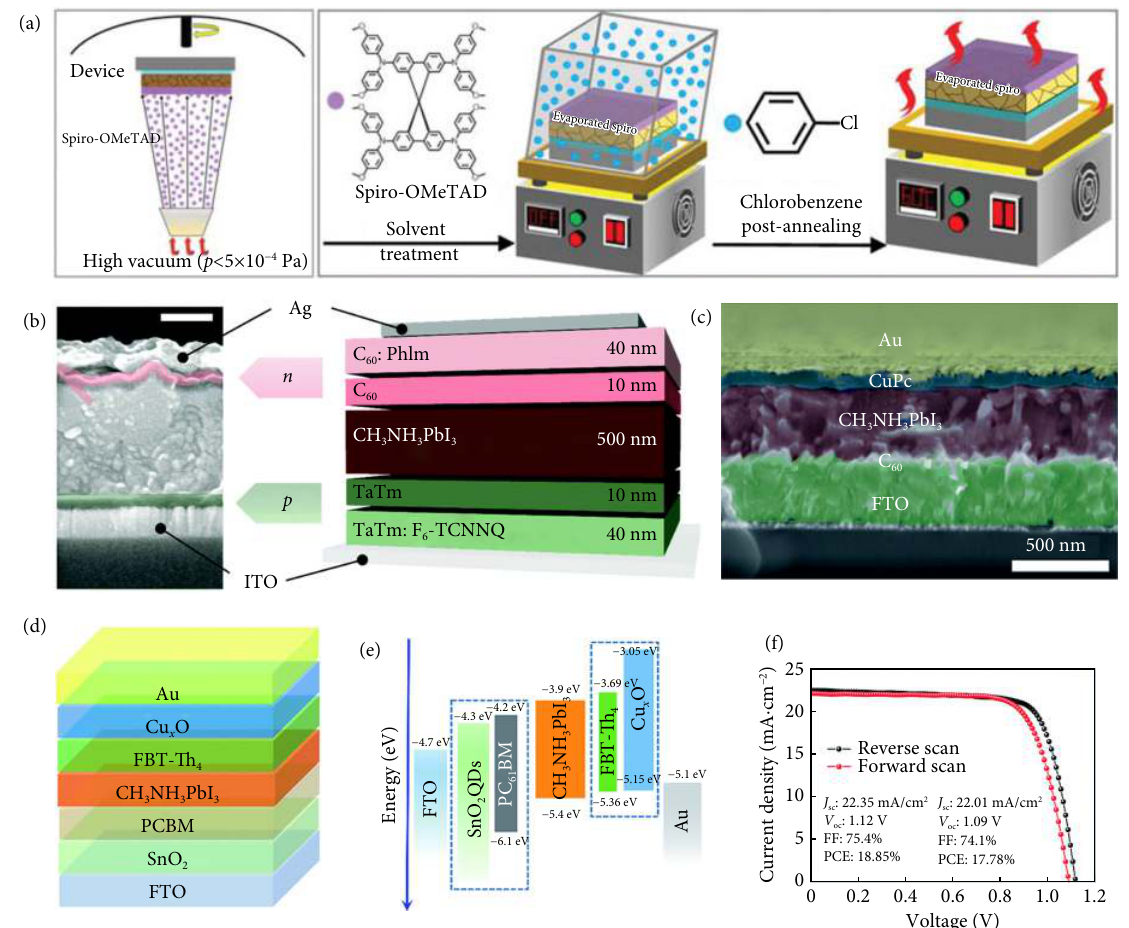
Fig. 4 Thermal evaporation for CTLs. (a) Schematic illustration of thermally evaporated spiro-OMeTAD and solvent treatment by chlorobenzene (reprinted with permission from ref. [48], © 2022 Wiley‐VCH). (b) Cross-sectional SEM image and device structure of fully-evaporated inverted PSC (reprinted with permission from ref. [55] © 2016 The Royal Society of Chemistry). (c) Cross-sectional SEM image of PSC with thermally-evaporated CuPc as HTL (reprinted with permission from ref. [53], © 2015 The Royal Society of Chemistry). ( d , e and f ) Schematic illustration (d) , energy band diagram (e) and J–V curve (f) of PSCs with Cu x O as HTL (reprinted with permission from ref. [54] © 2018 The Royal Society of thermal evaporation. They vacuum deposited fullerene (C ) and 60 bathocuproine (BCP) as ETL, and achieved PCEs of 19.4% and